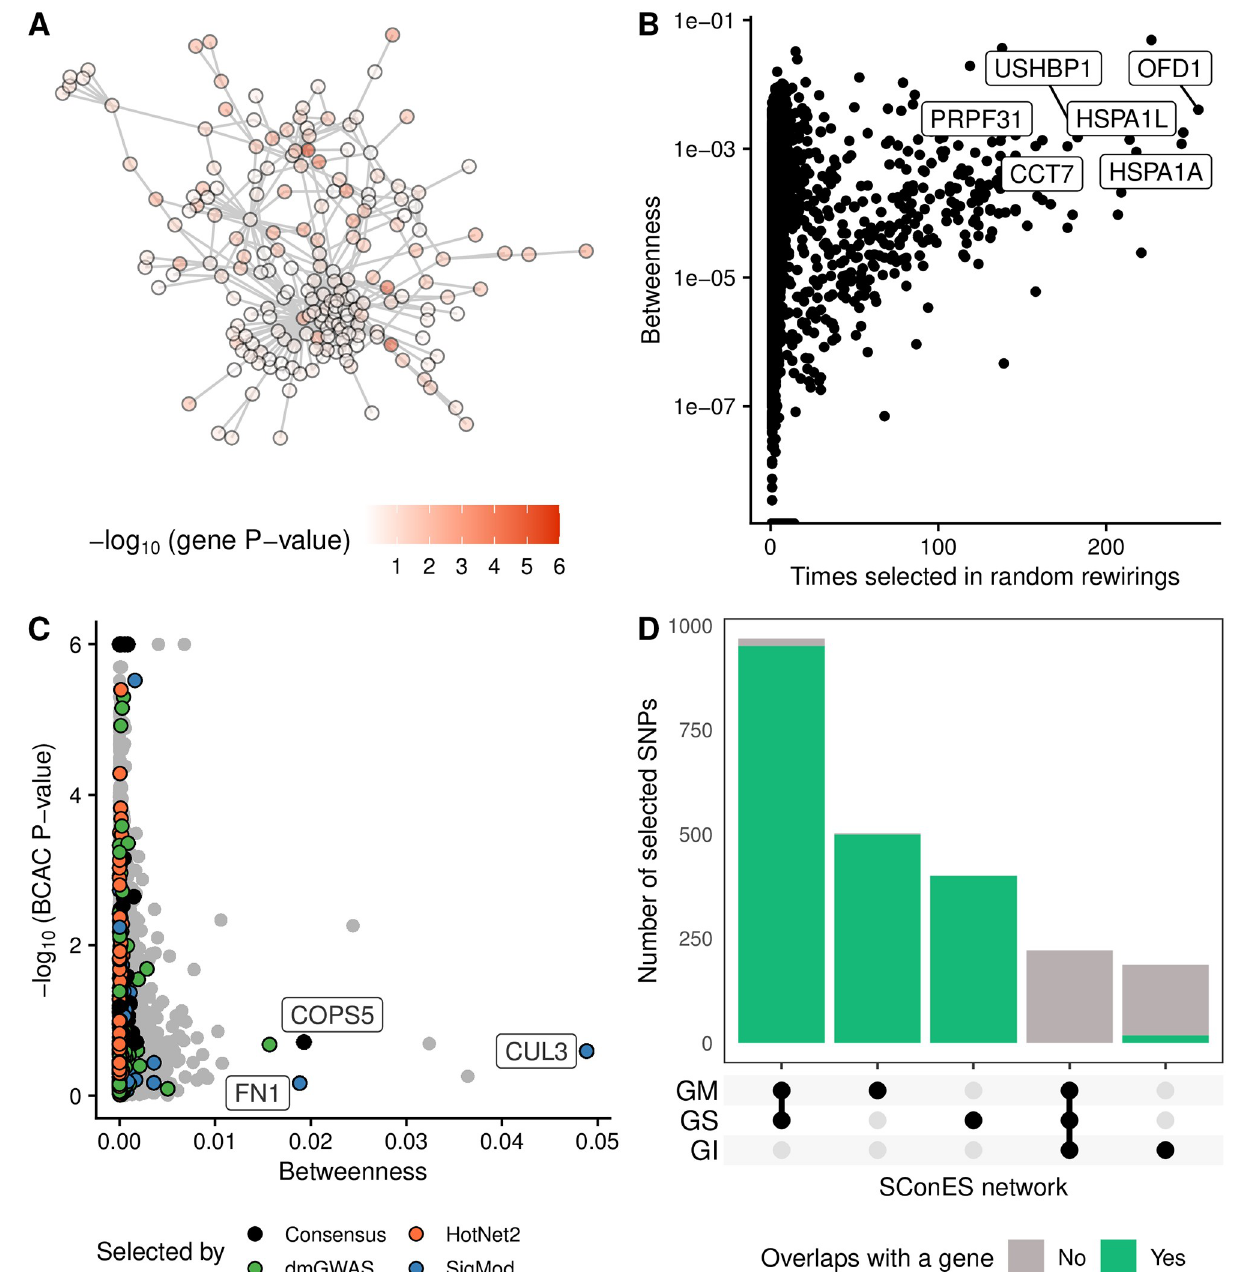
Fig 4. Drawbacks encountered when using network methods. (A) DmGWAS solution, with the genes colored according to the -log 10 of their P-value. (B) Number of times a gene was selected by either dmGWAS, heinz, LEAN, or SigMod in 100 rewirings of the PPIN (Section 2.4) and its betweenness. (C) Betweenness and -log 10 of the VEGAS2 P-value in BCAC for each of the nodes in the PPIN. We highlighted the genes selected by each method and the ones selected by more than one (“Consensus”). We labeled the three most central genes that were picked by any method. (D) Overlap between the solutions of SConES GS, GM, or GI. Barplots are colored based on whether the SNPs map to a gene or not (Section